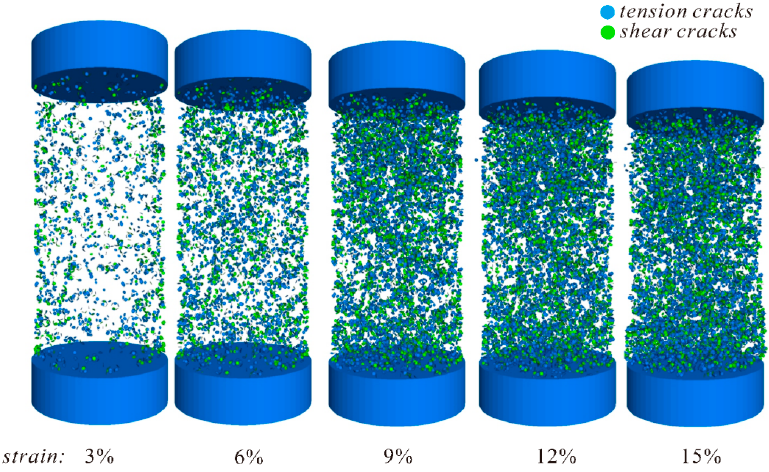
Figure 8. Crack development in undisturbed soil under 300 kPa confinement.